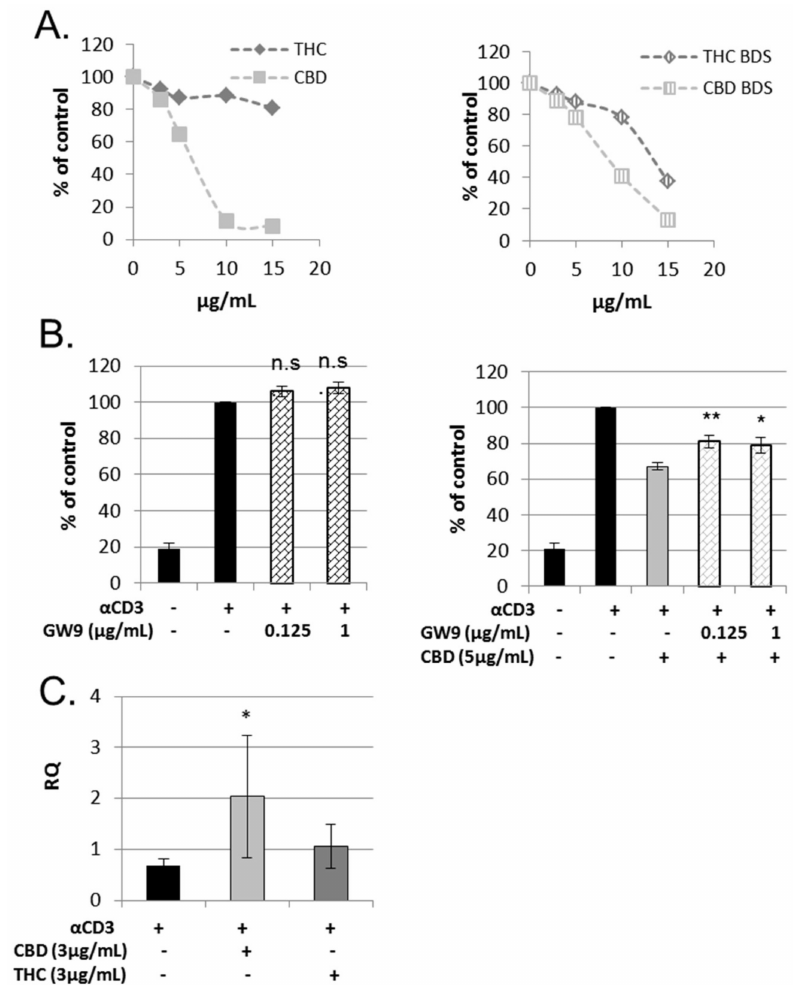
Figure 3. Receptors involved in THC and CBD’s effect on lymphocyte proliferation. ( A ) Proliferation of CFSE-stained, 4 days CD3-activated, splenocytes from CB2 knockout mice was analyzed using flow cytometry. Summary of four independent experiments. The differences of CBD, THC BDS and CBD BDS as compared to control are significant starting from 3 µ g/mL. The differences of THC as compared to control are significant starting from 10 µ g/mL. The differences of THC when compared to CBD is significant starting from 3 µ g/mL. ( B ) The influence of PPAR γ antagonist, GW9662, on CBD’s effect on lymphocyte activation. Proliferation of CFSE-stained, CD3-activated murine splenocytes was analyzed using flow cytometry analysis. Summary of eight independent experiments. p Value—samples were compared to act spl + CBD (right) or act spl (left). ( C ) Real time PCR analysis for the expression of cyp1a1 in activated splenocytes treated with THC or CBD. Summary of four independent experiments. Results are expressed as mean + SEM. p Value *, <0.05; **, <0.001;, act spl: activated splenocytes,